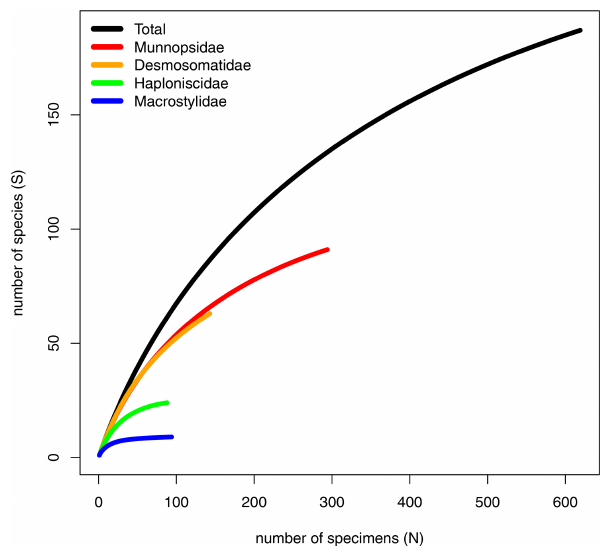
Figure 8. Rarefaction analysis by area considering all families to-